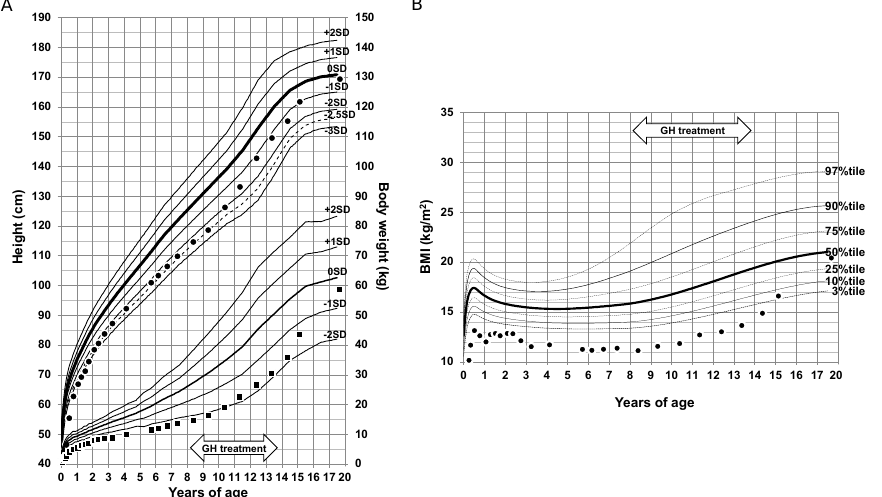
Figure 1. Growth curve of height and body weight from birth to the onset of diabetes. ( A ) Height and body weight. ●: height of the patient, ■: body weight of the patient. ( B ) Body mass index. ●: BMI of the patient. BMI, body mass index; GH, growth hormone; SD, standard deviation.